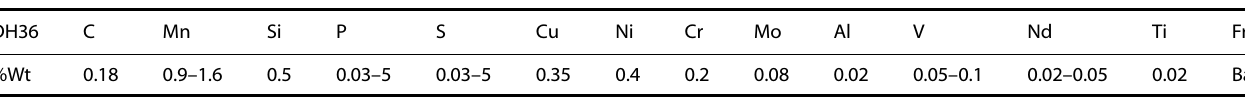
Table 3. Chemical composition of synthetic seawater following ASTM-98 (2013) standard 38 . Ions Cl − Na + SO 42 − Mg 2 + Ca 2 + K + HCO 3 − Br − Concentration/g.L −